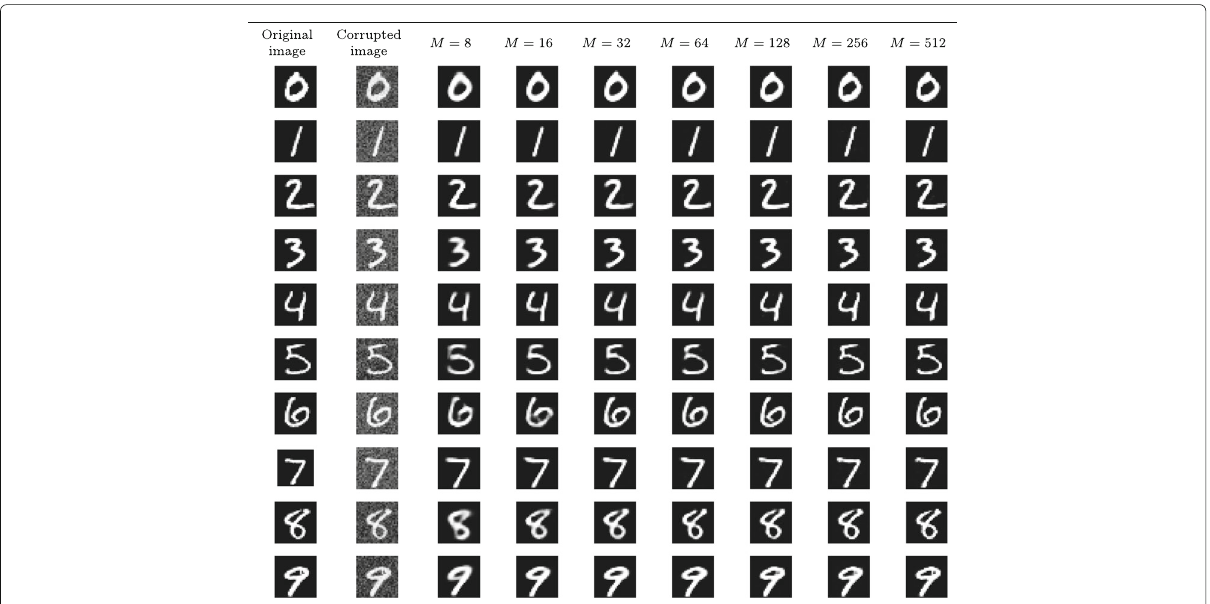
Fig. 6 Visual evaluation of the SSDAE_CS Layer_5 when λ